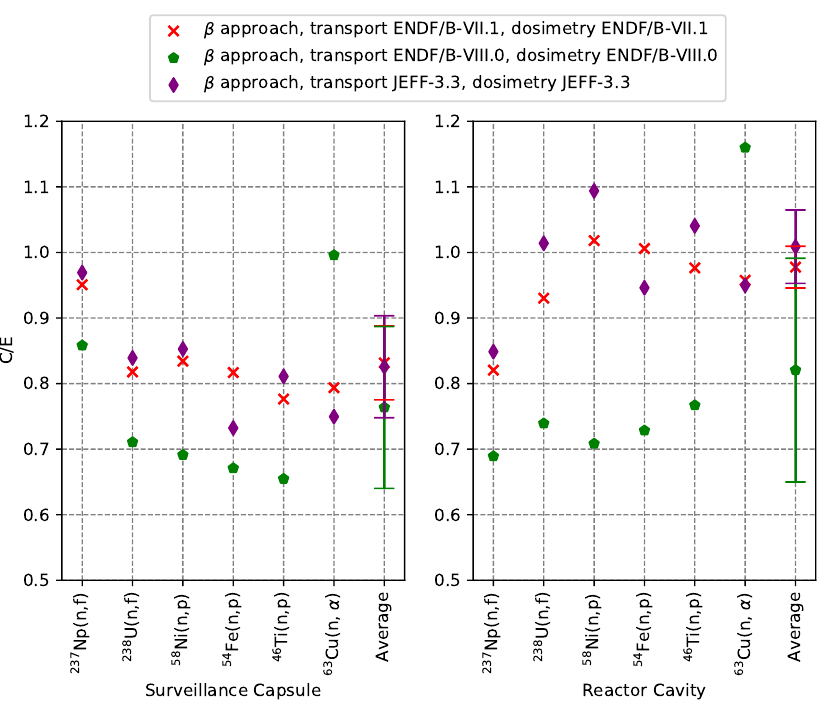
Figure 9. C/E ratios obtained with the β approach using the ENDF/B-VII.1, ENDF/B-VIII.0 and JEFF- 3.3 nuclear data libraries. The 237 Np(n,f) specific activity is not taken into account in the calculation of the average C/E value in the cavity.